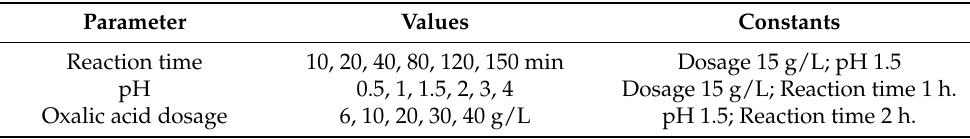
Figure 2. Schematic representation of precipitation test procedure. Table 2. Experimental design for the oxalic acid precipitation tests.